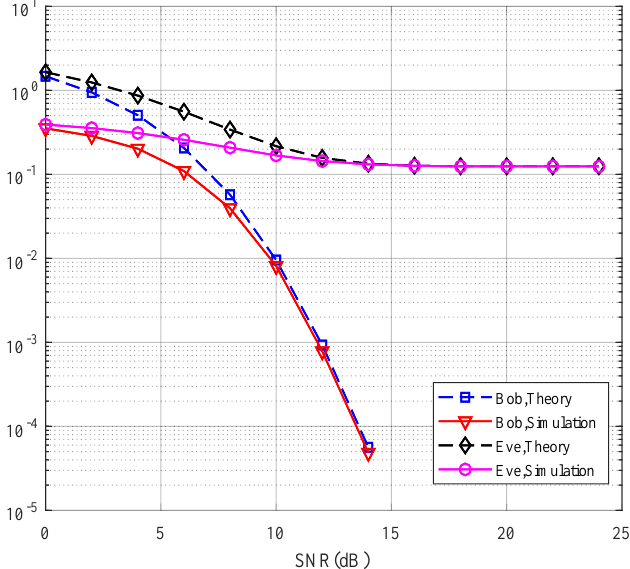
Figure 7. Bob’s and Eve’s theoretical and simulated BER performance for the proposed CIM-SDM scheme employing N t = 8, N r = 4, and